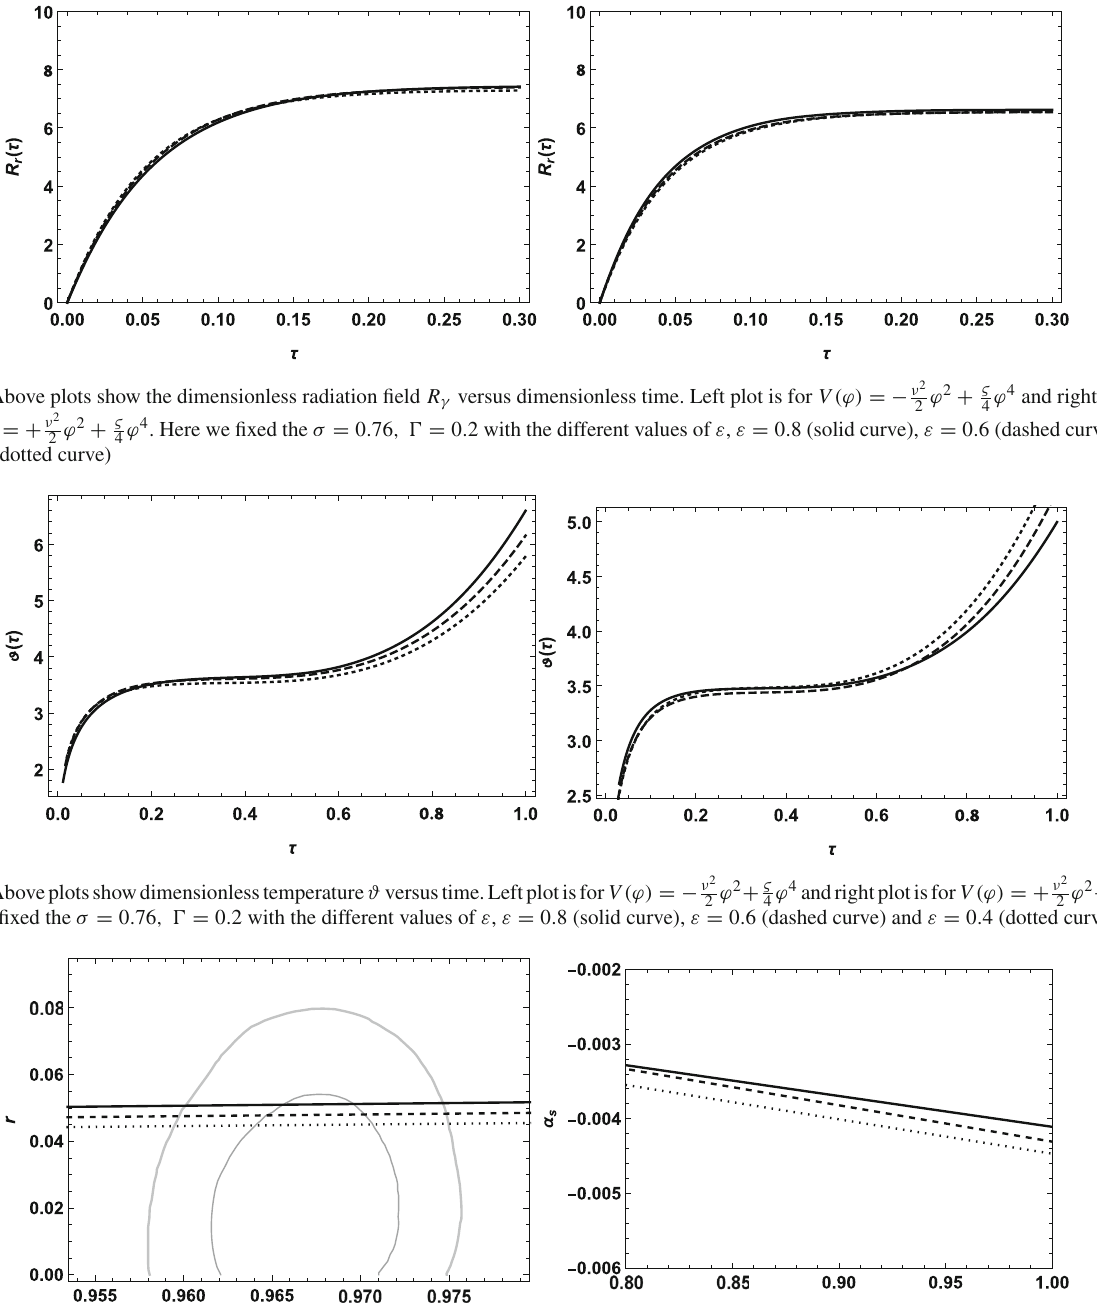
Fig. 6 Left plot shows r versus n s and right plot shows α s versus n s . Here we fixed the σ = 0 . 76 ,(cid:8) = 0 . 2 with the different values of ε , ε = 0 . 8 (solid), ε = 0 . 6 (dashed) and ε = 0 . 4